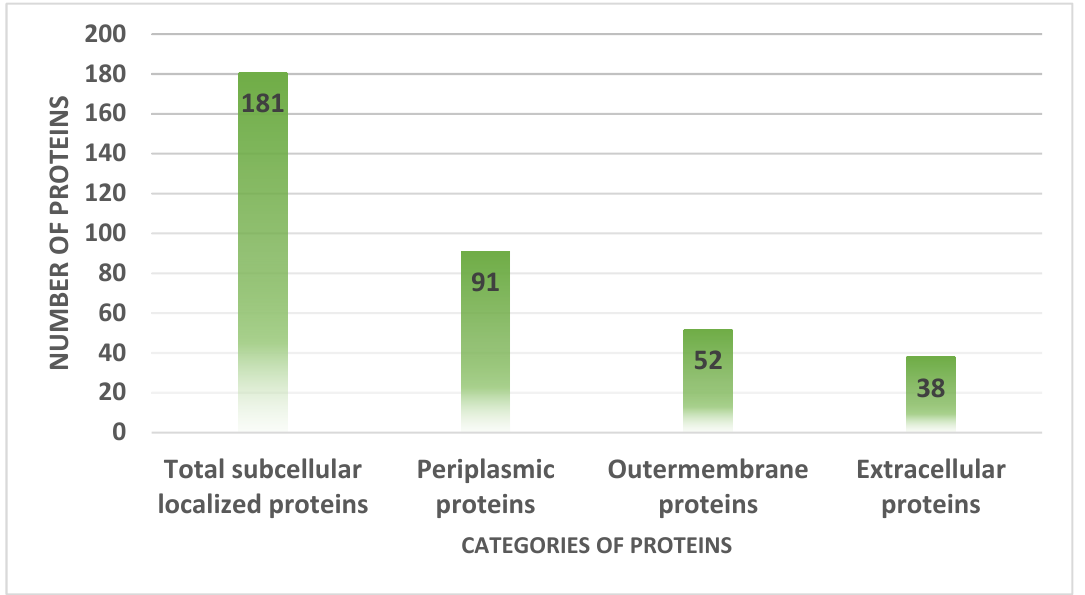
Figure 5. Number of proteins present in extracellular matrix, periplasmic space and extracellular membranes.